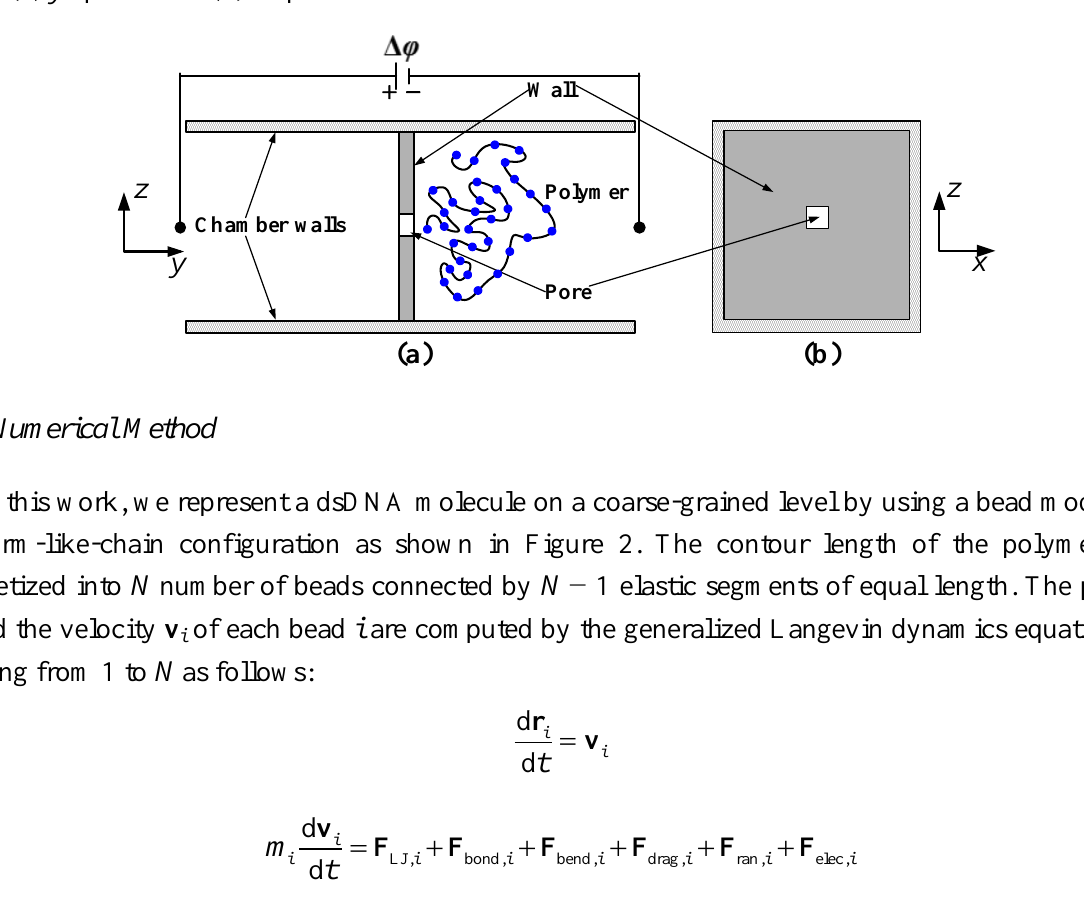
Figure 1. Sectional view illustrating the simulation set-up used in the present work: ( a ) yz -plane and ( b ) xz